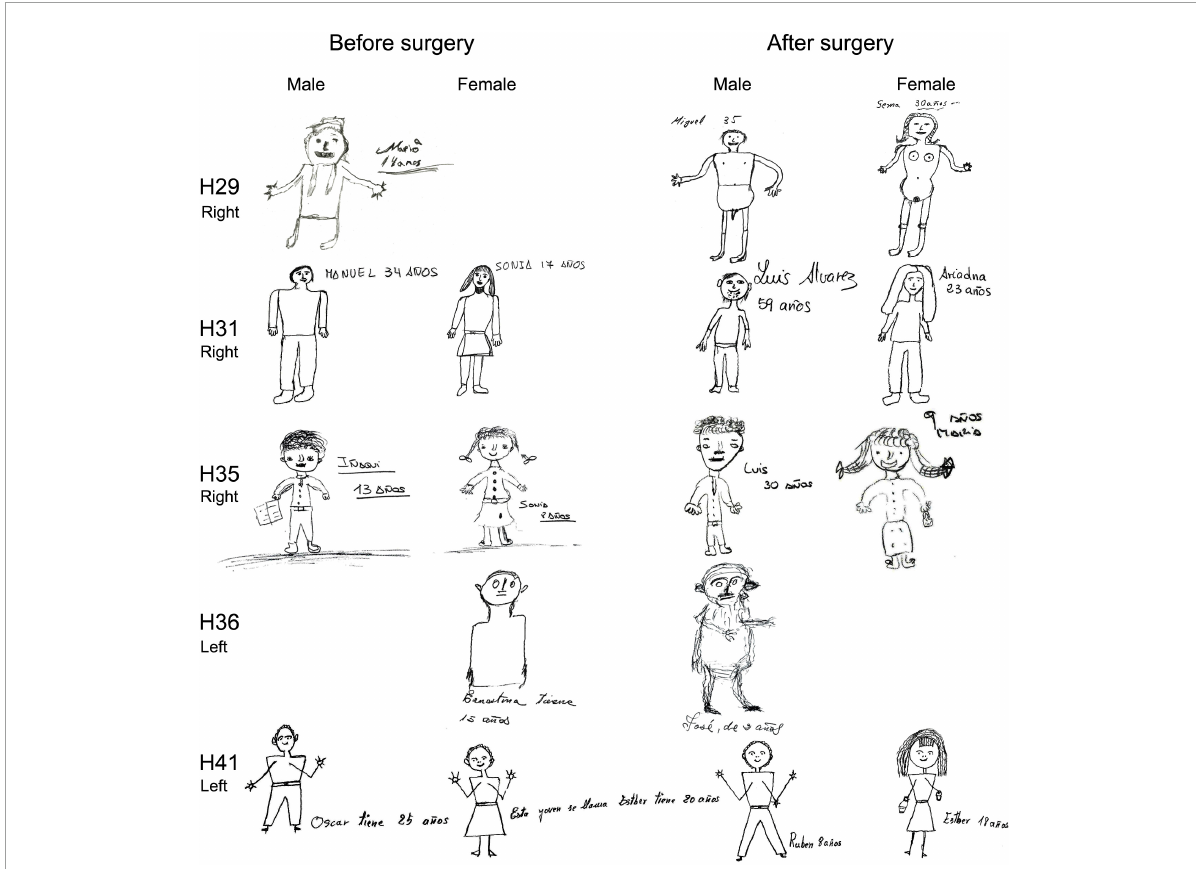
FIGURE8 Person (male, female) drawings of the H-T-P test (before and after surgery) performed by NoHS-patients that became seizure-free after surgery. All patients were right-handed. Patients were asked to draw both genders. Patient H29 only performed one drawing; when asked for the other gender, he changed the name (Mario to Maria). After surgery this patient showed disinhibition (nude male and female). H36 had difficulty to draw and only did one. All patients had difficulties to perform the drawings except H31. The size of the original drawings was not